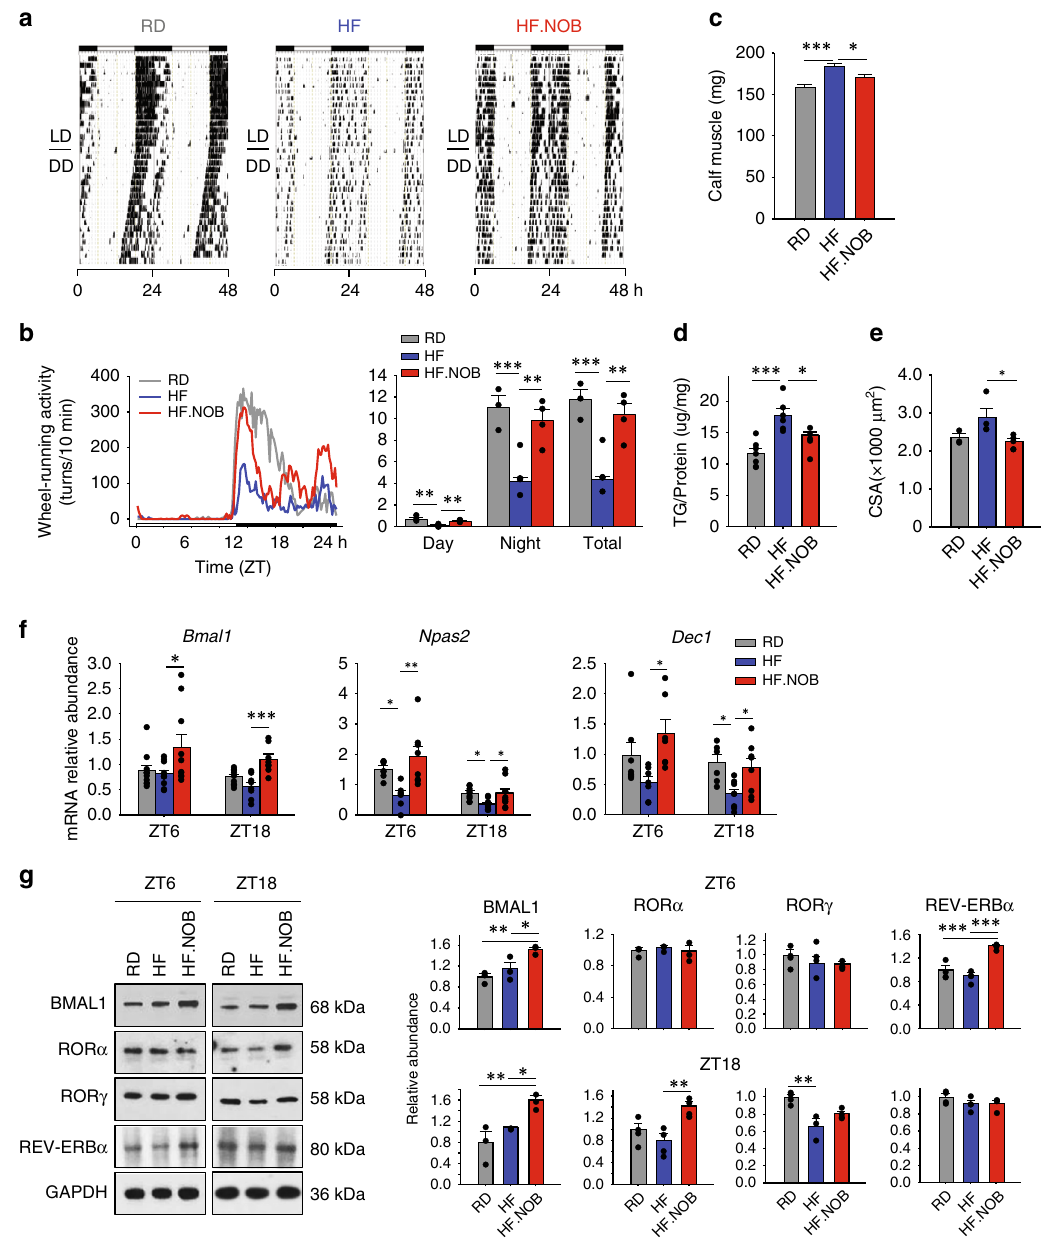
Fig. 3 NOB enhanced circadian rhythms in skeletal muscle. Aged mice were fed with regular diet (RD), high-fat (HF) diet, or HF diet with NOB (HF.NOB). a Wheel-running activity (WRA) analysis. Representative actograms are shown ( n = 4, 6, and 6 for RD, HF, and HF.NOB, respectively). b Circadian wheel- running activity was calculated from a by using the ActiView software ( n = 4, 6, and 6 for RD, HF, and HF.NOB, respectively). c Calf muscle mass were measured after 20 weeks of treatment ( n = 20, 15, and 15 for RD, HF, and HF.NOB, respectively). d Triglyceride contents in calf muscle ( n = 7, 6, and 4 for RD, HF, and HF.NOB, respectively). e Fiber size ( n = 3, 4, and 5 for RD, HF, and HF.NOB, respectively). f Expression of Bmal1 , Npas2 , and Dec1 genes (ZT6, n = 11, 10, and 10 for RD, 10 HF, and 10 HF.NOB, respectively; ZT18, n = 9, 8, and 8 for RD, HF, and HF.NOB, respectively). g Representative BMAL1, ROR α , ROR γ , and REV-ERB α protein levels and quanti fi cation results are shown ( n = 3). * p < 0.05, ** p < 0.01, *** p < 0.001, one-way ANOVA. Data are presented as mean ± SEM in bar